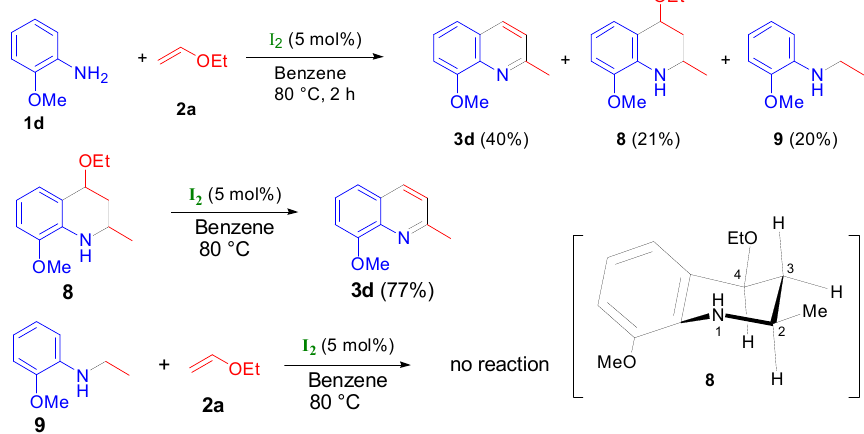
Scheme 1. Reactions of by-products 8 and 9 with iodine under the same conditions.